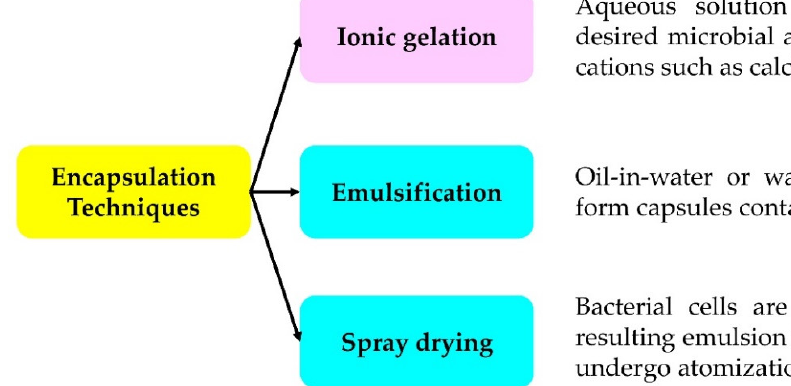
Figure 2. Diagram of encapsulation techniques of plant growth-promoting microorganisms.